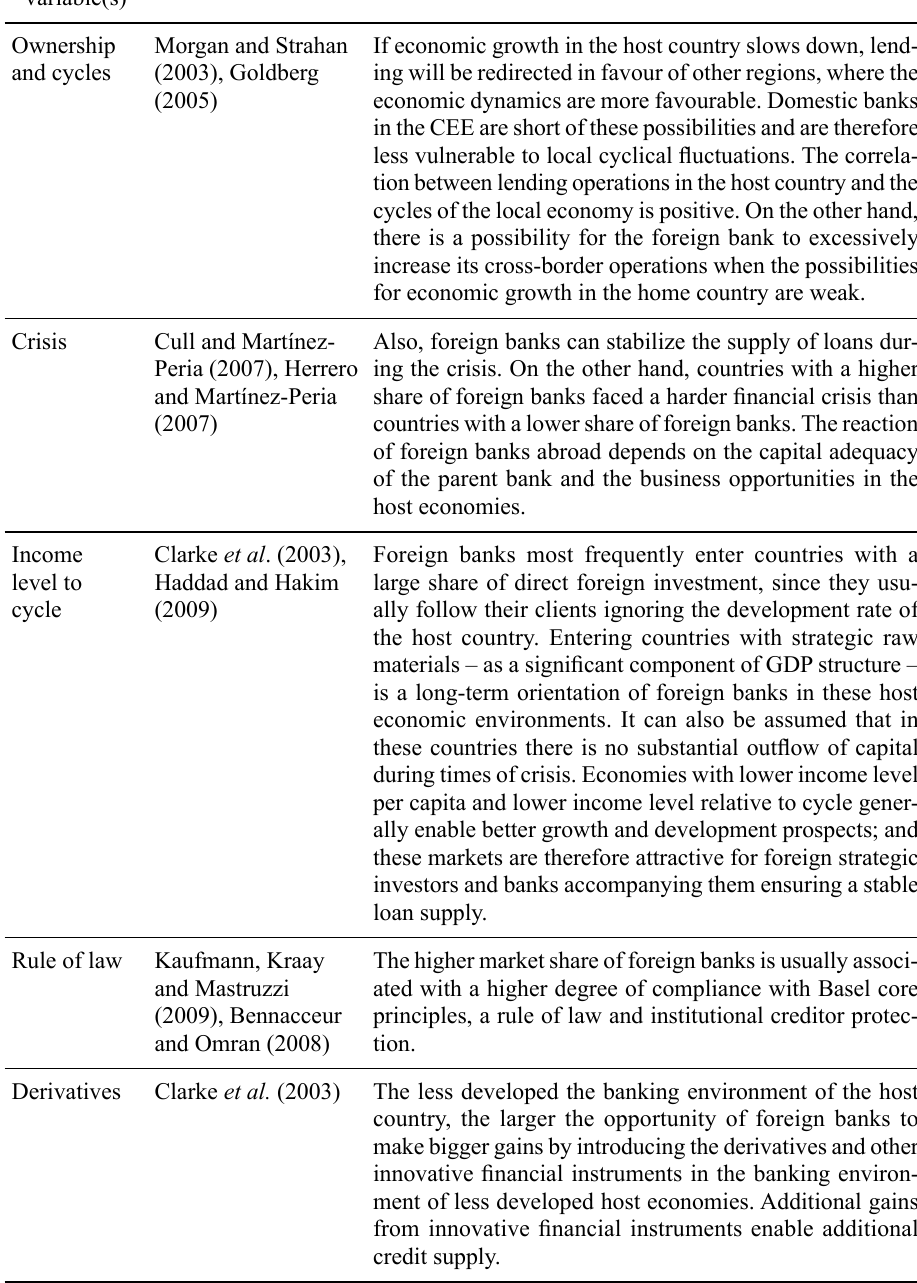
Table 2. Overview of the literature on explanatory variables of the stability of loan supply Explanatory